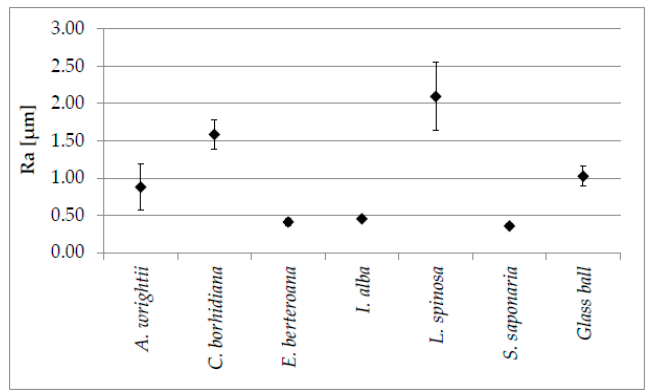
Figure 2. Mean roughness (Ra) of the profiles of six drifting seed species and their standard deviations ( n = 5) in comparison to the reference glass ball determined by means of the digital elevation models. (Standard deviation of E. berteroana, I. alba and S. saponaria are not visible; <9% of the mean).